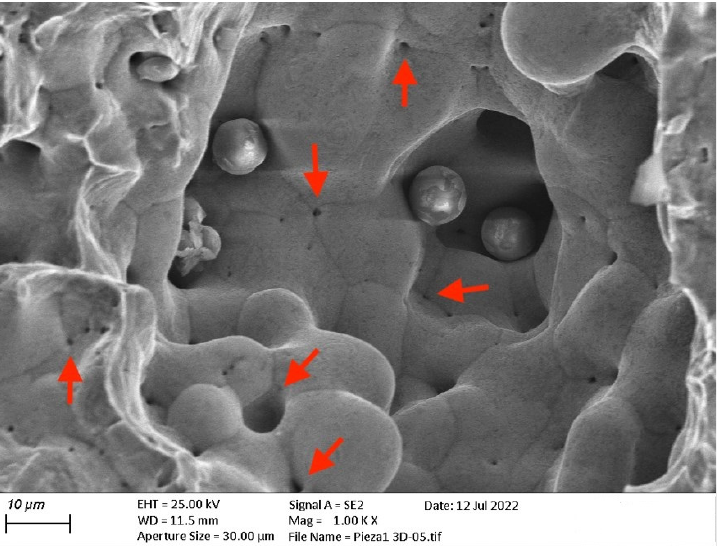
Figure 16. FESEM images of micro-voids (marked with arrows) and bonding interphases in fractured ADAM copper cubic sample.